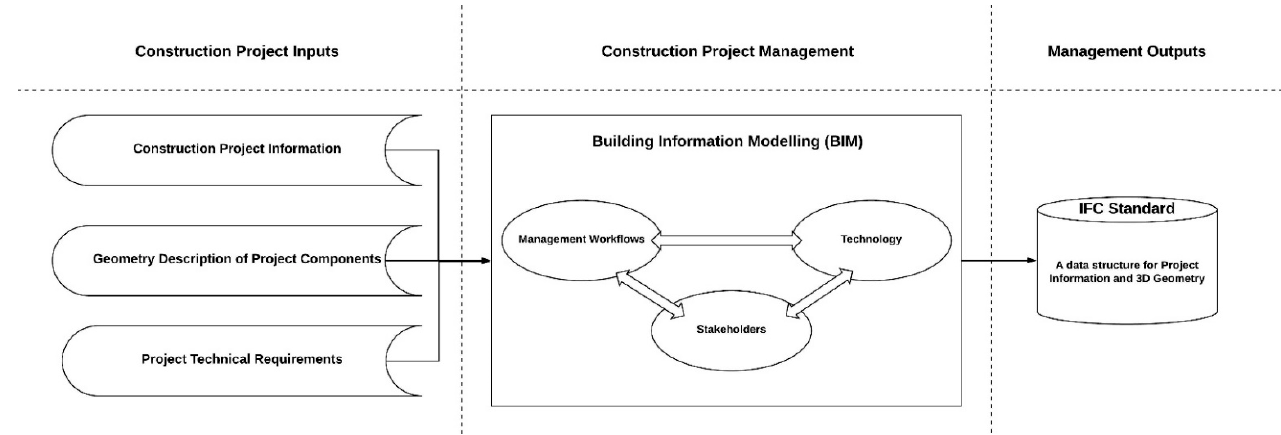
Figure 1. Relation between BIM and IFC standard.